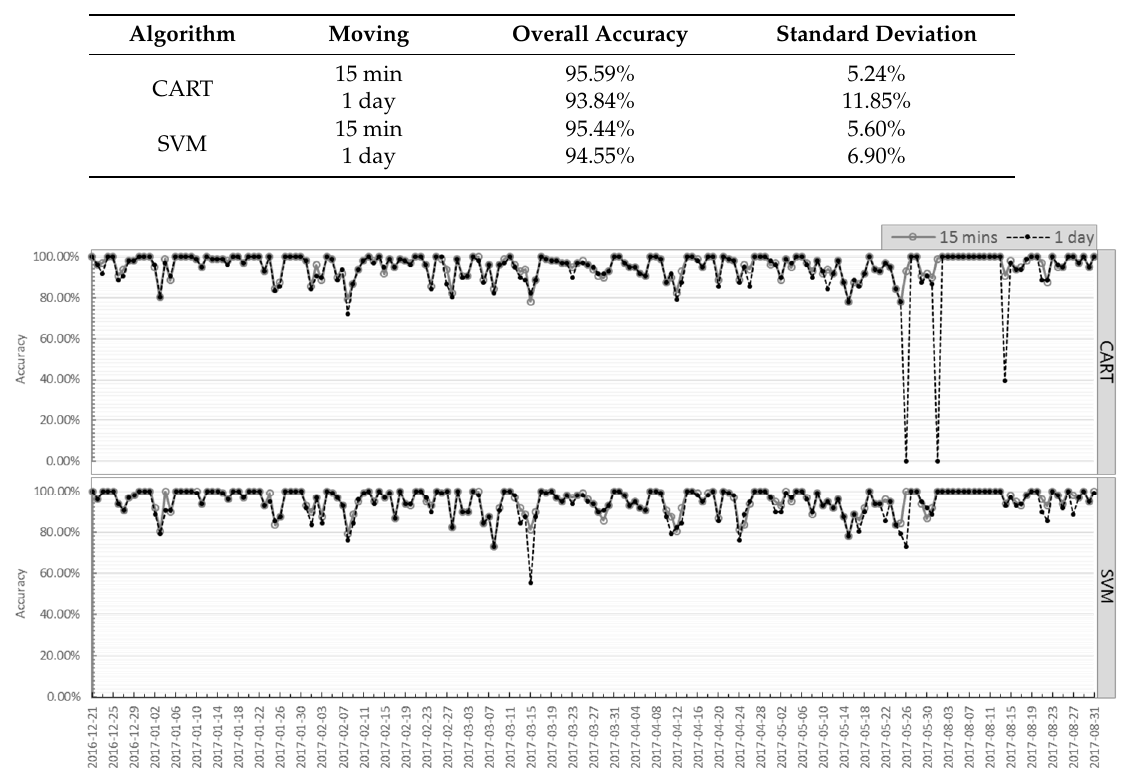
Figure 7. Comparison of daily accuracy of occupancy estimation by classification algorithms and window moving intervals.